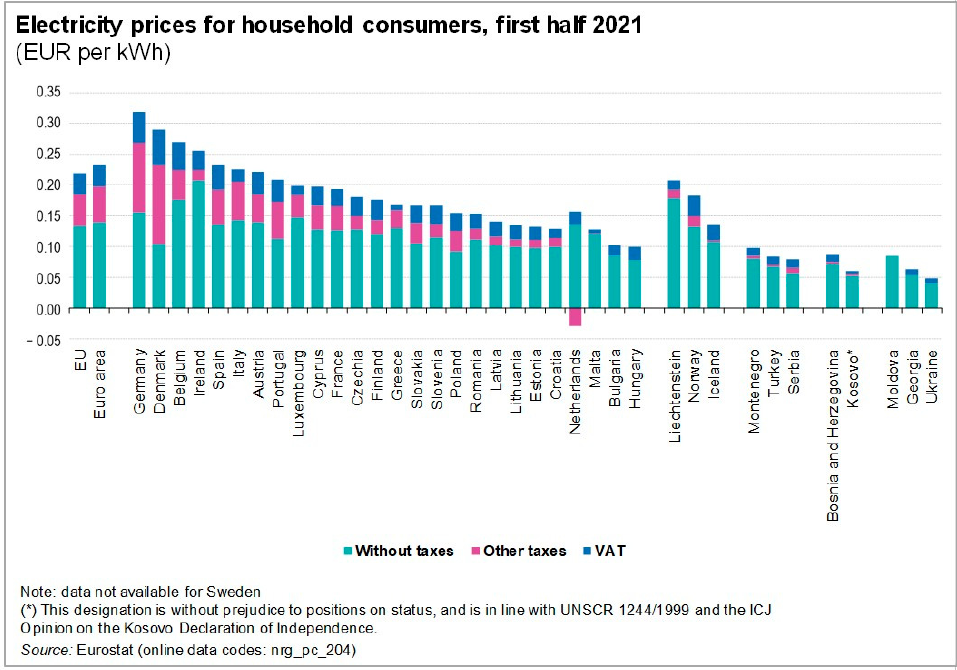
Figure 7. Electricity prices for household consumers, first half 2021 [29].